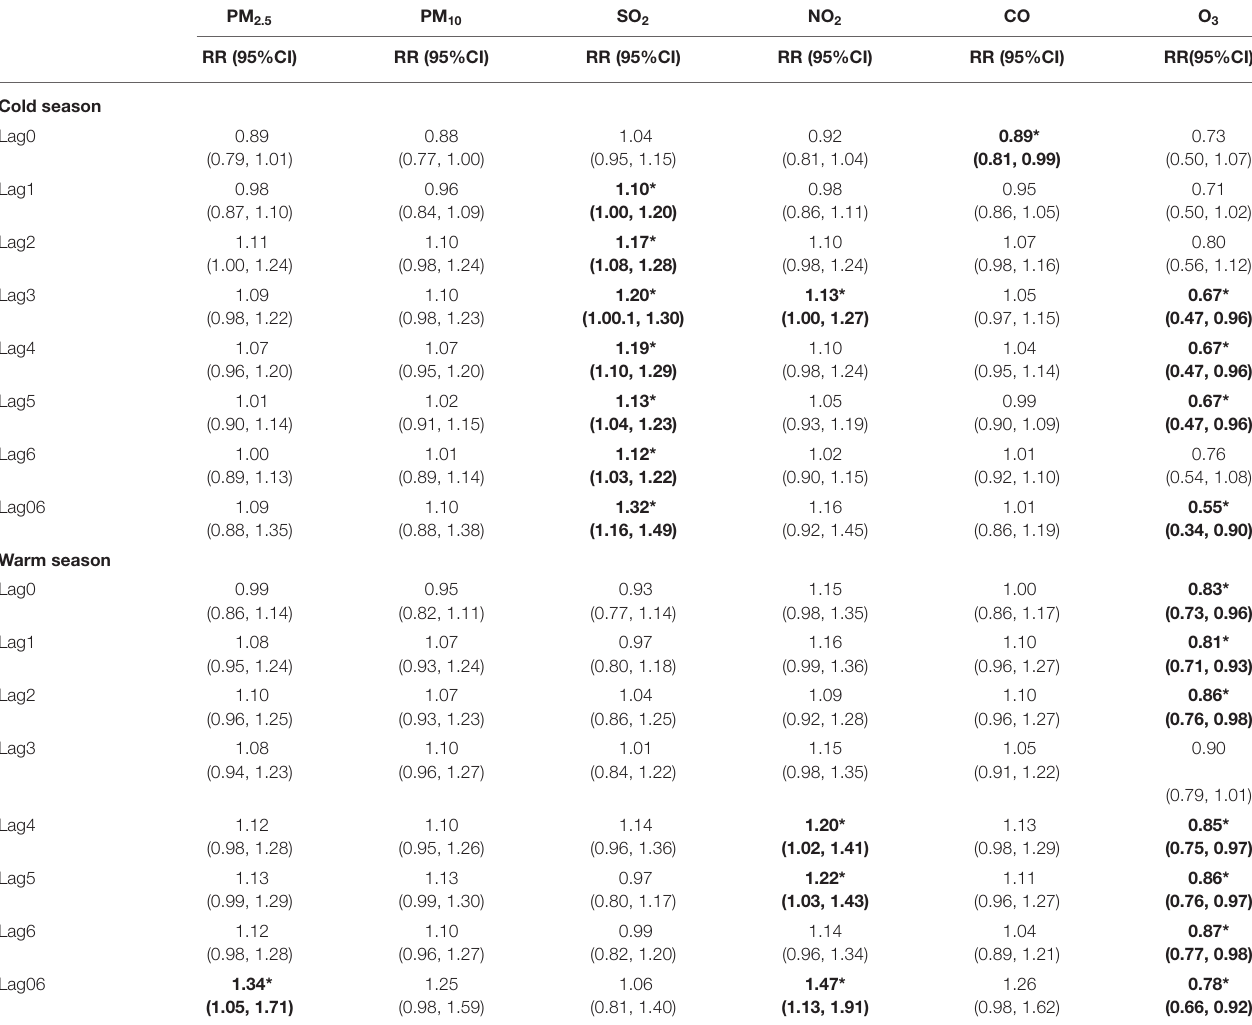
TABLE 7 | The relative risk (RR) of hospital admission for asthma in children per interquartile range (IQR) increase in different air pollutants in different lag days: single-pollutant model, stratified by season. PM